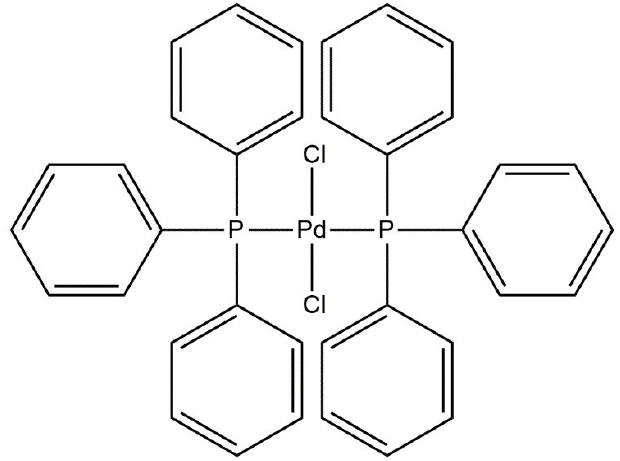
Figure 11. Simplified formula of the palladium complex used during ibuprofen synthesis.